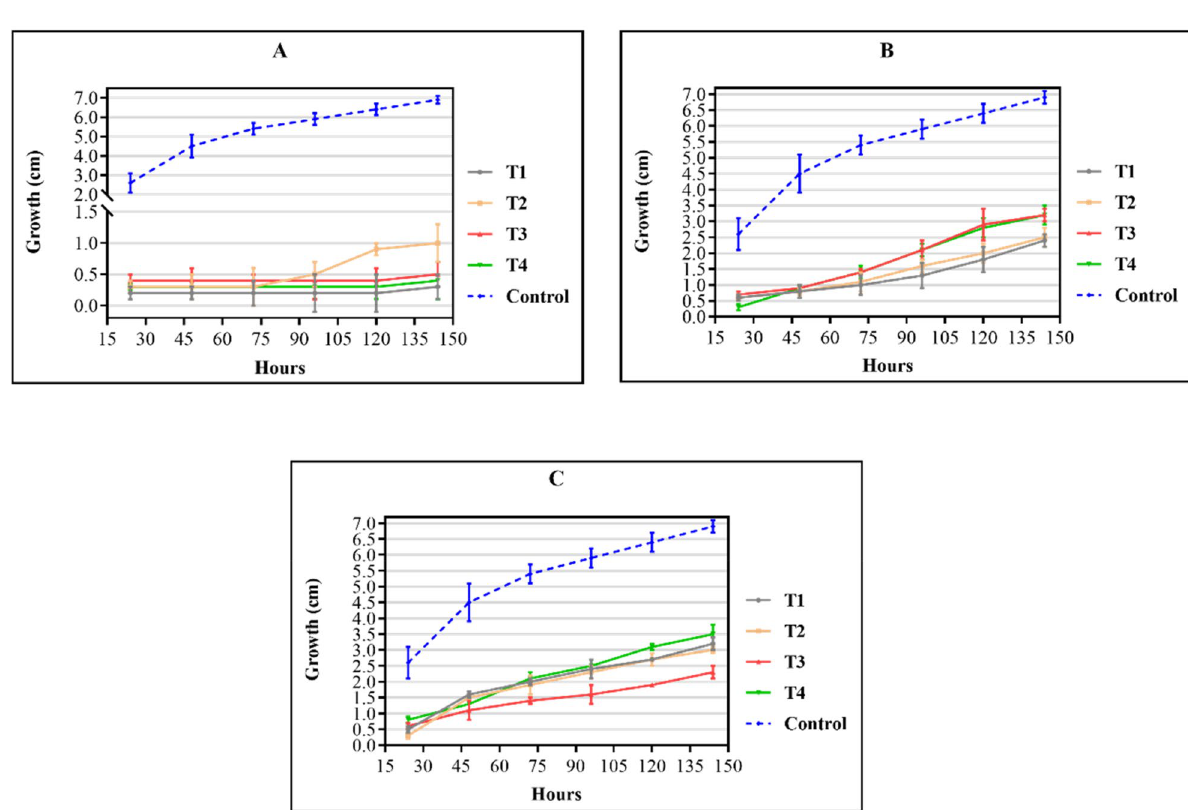
Figure 4. Antifungal activity of three different concentrations of the compounds against Fusarium oxysporum determined using the poisoned food method. ( A ) 10% concentration, ( B ) 7% concentration, and ( C ) 5% concentration. Control: the growth of filamentous fungi in a medium without drugs. Values are means (n = 3) ± standard